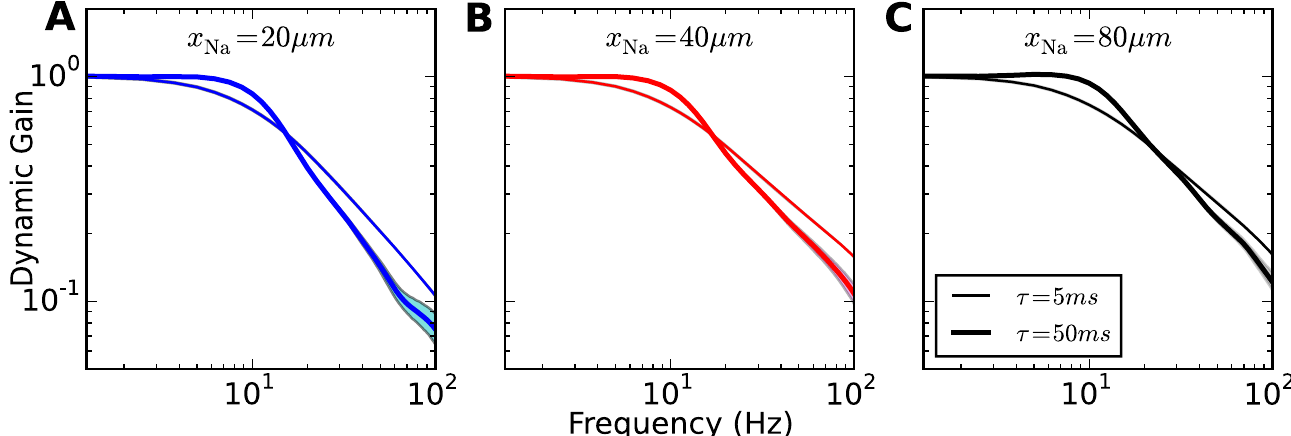
Fig 6. Impact of background current correlation time on dynamic gain. Dynamic gain functions for different input current correlation times. Model properties as for Fig 2. x Na increases from = 20, 40 to 80 μ m ( A , B , C ). Line width indicates input correlation time (thin: τ = 5ms, wide: τ = 50ms).